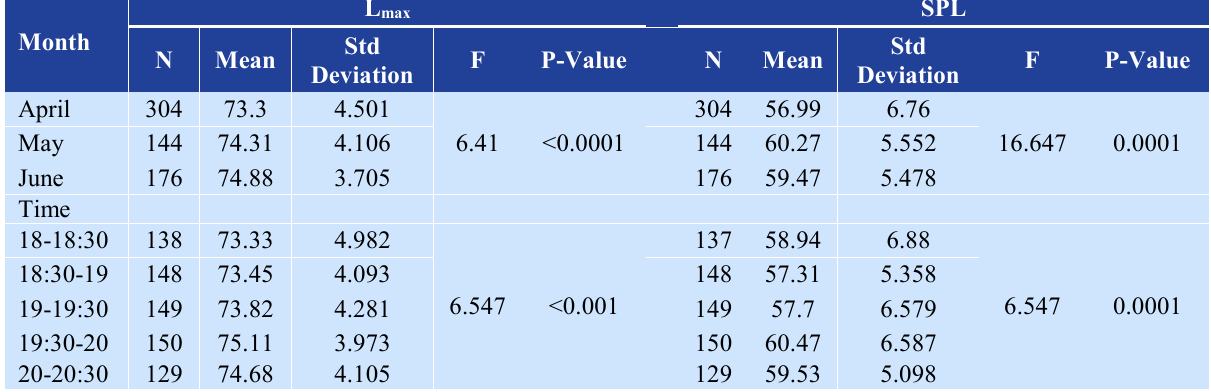
Table 3. Statistical analysis of the measured Lmax and SPL at different hours and months